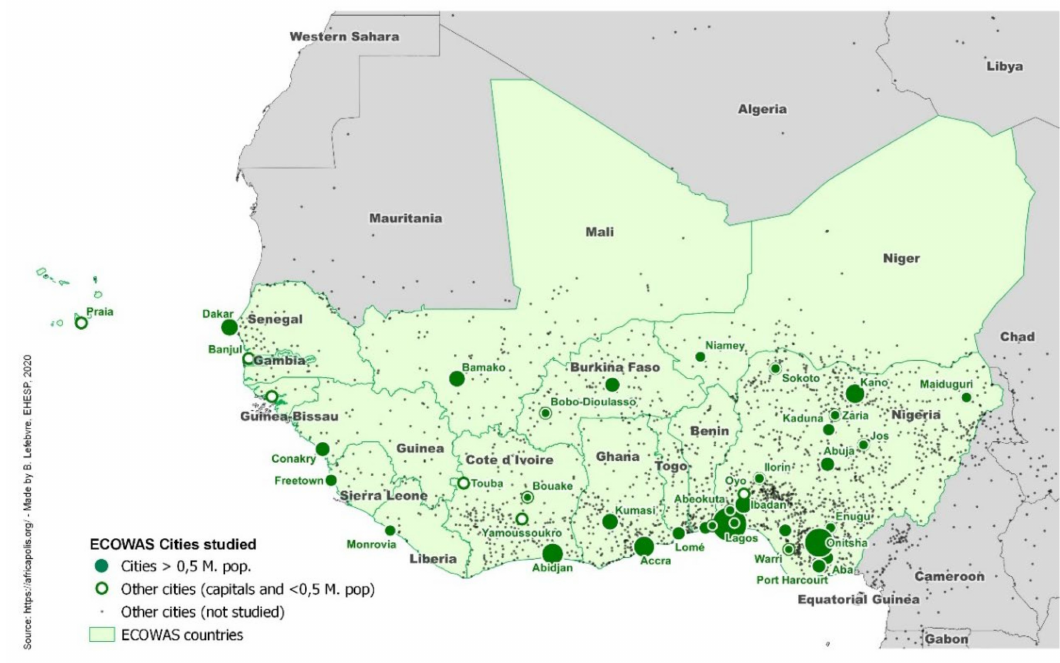
Figure 1. Economic Community of West African States (ECOWAS) urban system and cities selected for the